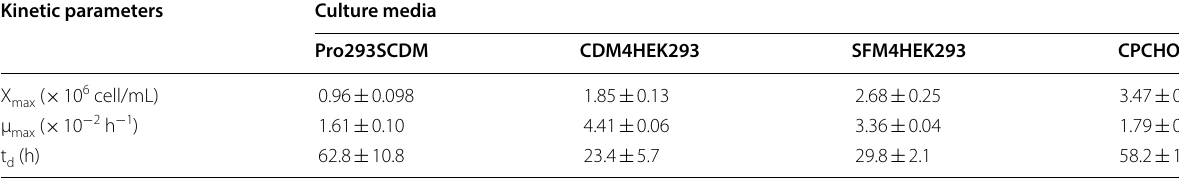
Each value represents the average from four determinations X max , maximum cell density; µ max , maximum specific growth rate; t d , cell doubling time